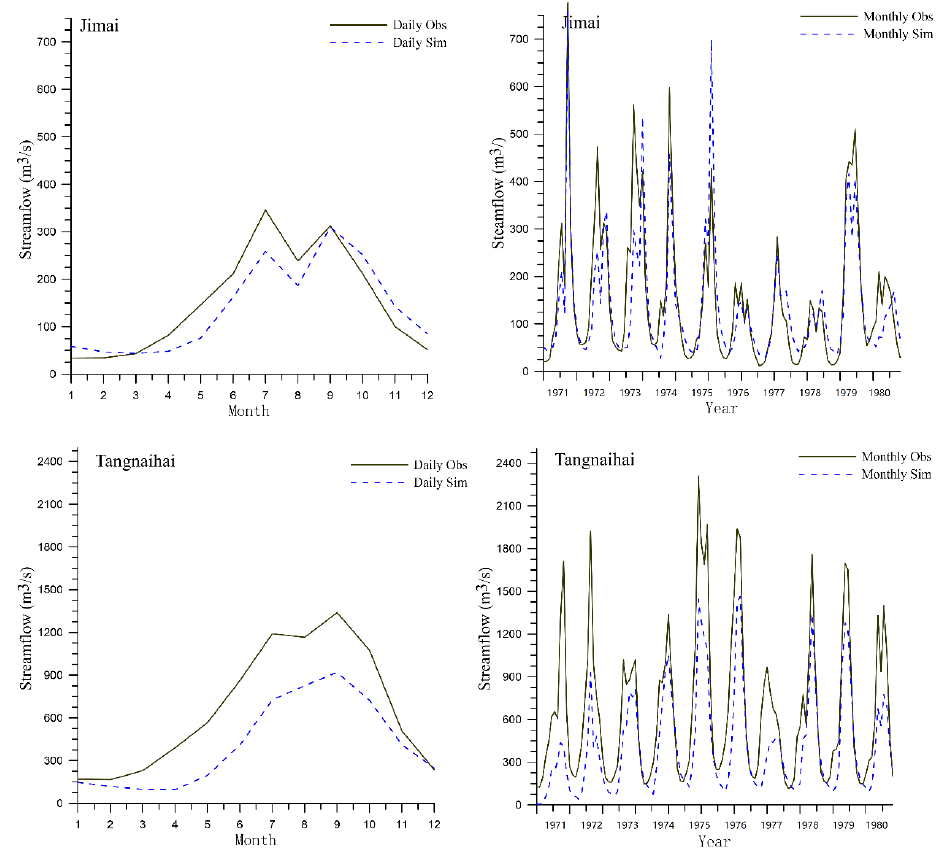
Figure 2. Simulated (sim) and observed (obs) streamflow for the three sub-basins of TRHR during the calibration period (1971 – 1980).